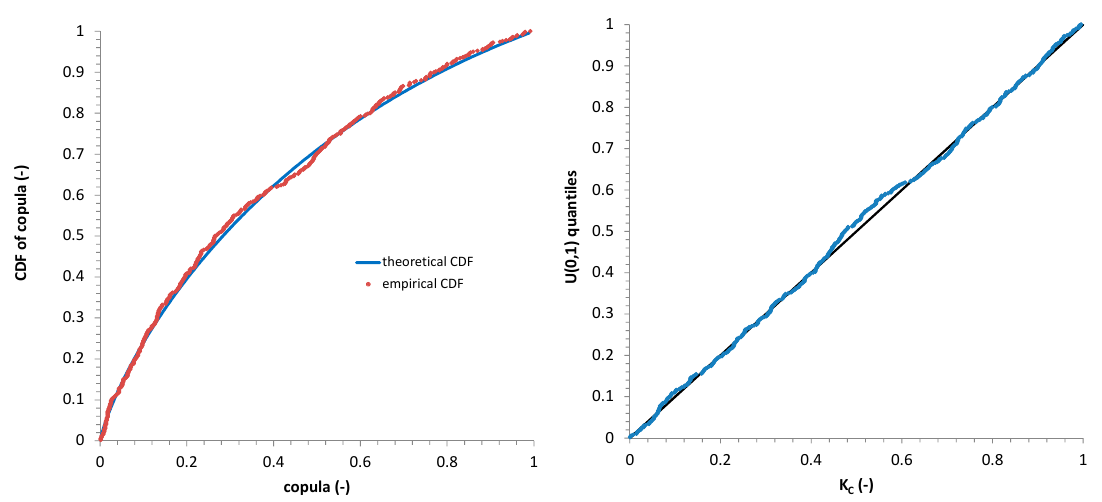
Figure 6 . Performance of Gumbel copula, in terms of Kendall function K C (-) (which represents the CDF of copula function), on probabilistic plot ( left ) and Q-Q plot ( right ).